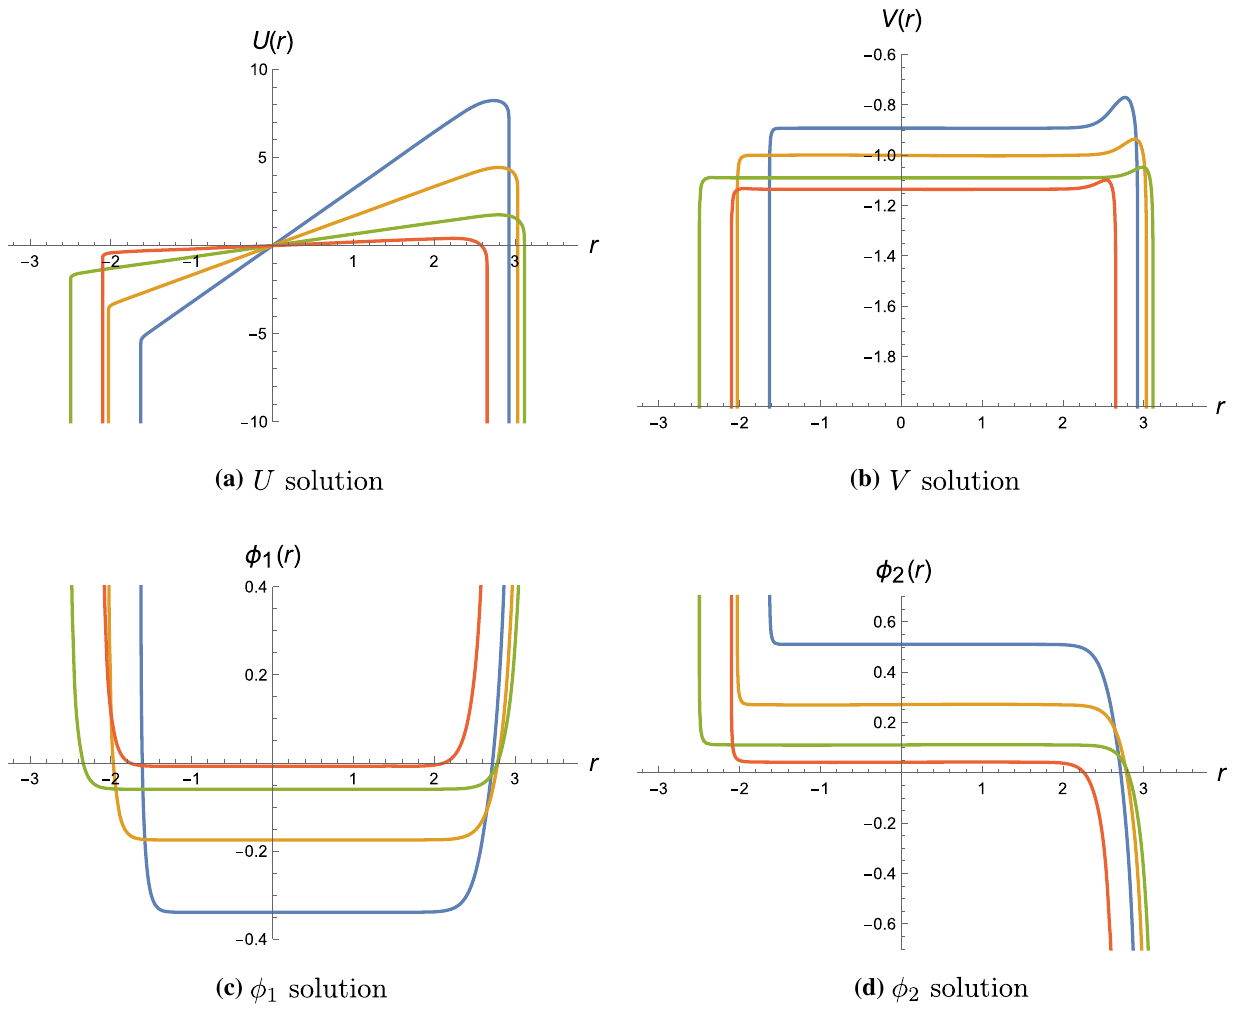
Fig. 28 RG flows between AdS 3 × CP 2 fixed points and curved domain walls for SO ( 2 ) × SO ( 2 ) twist in SO ( 3 , 2 ) gauge group. The blue, orange, green and red curves refer to p 2 = − 1